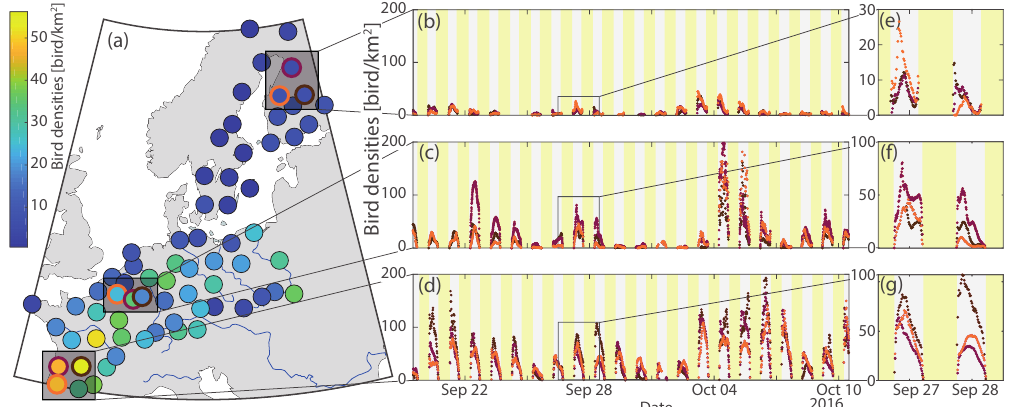
Figure 2. Illustration of the spatio-temporal variability of bird densities measured by a weather radar network. ( a ) Average bird densities measured by each radar over the whole study period. ( b – d ) Time series of bird densities measured by the radar with the corresponding outer ring color in panel ( a ). ( e – g ) Zoom on a two-days period. A strong continental trend appears in panel ( a ) as well as a correlation at the multi-night scale when comparing ( b – d ). These spatial correlations are even stronger at the regional scale when comparing within a subplot ( f ). The intra-night scale shows an obvious bell-shape curve pattern during each night ( g